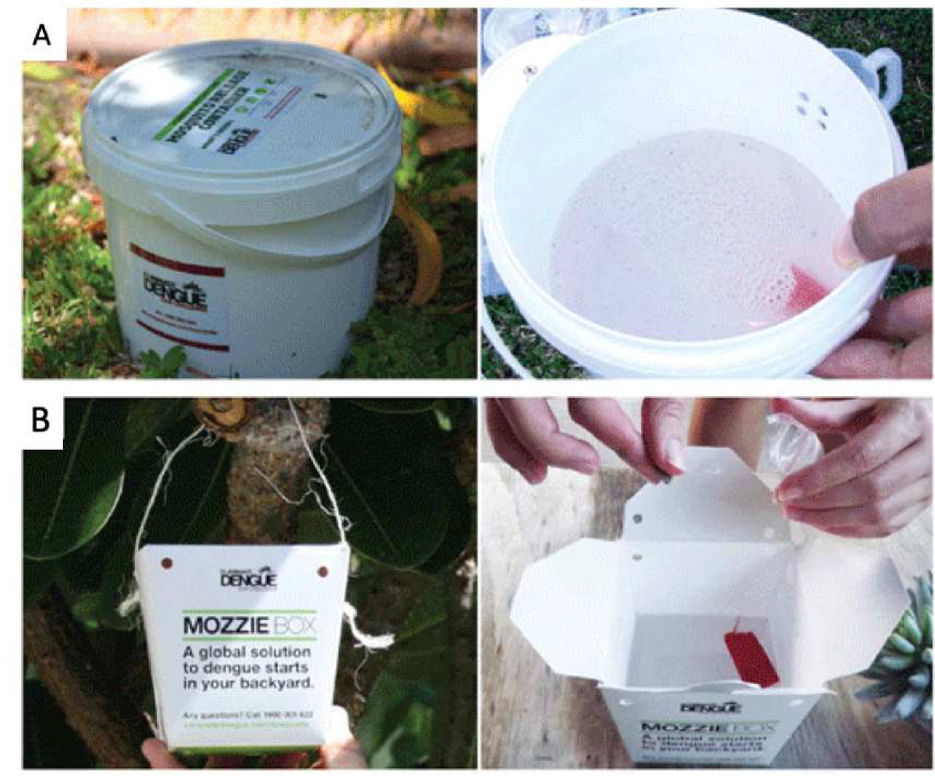
Figure 4. Mosquito-release containers. Photos illustrating different mosquito release containers used in the deployment. Bucket mosquito release container (MRC) ( A ) Single use Mozzie Box MRC ( B ) (O’Neill et al. ,